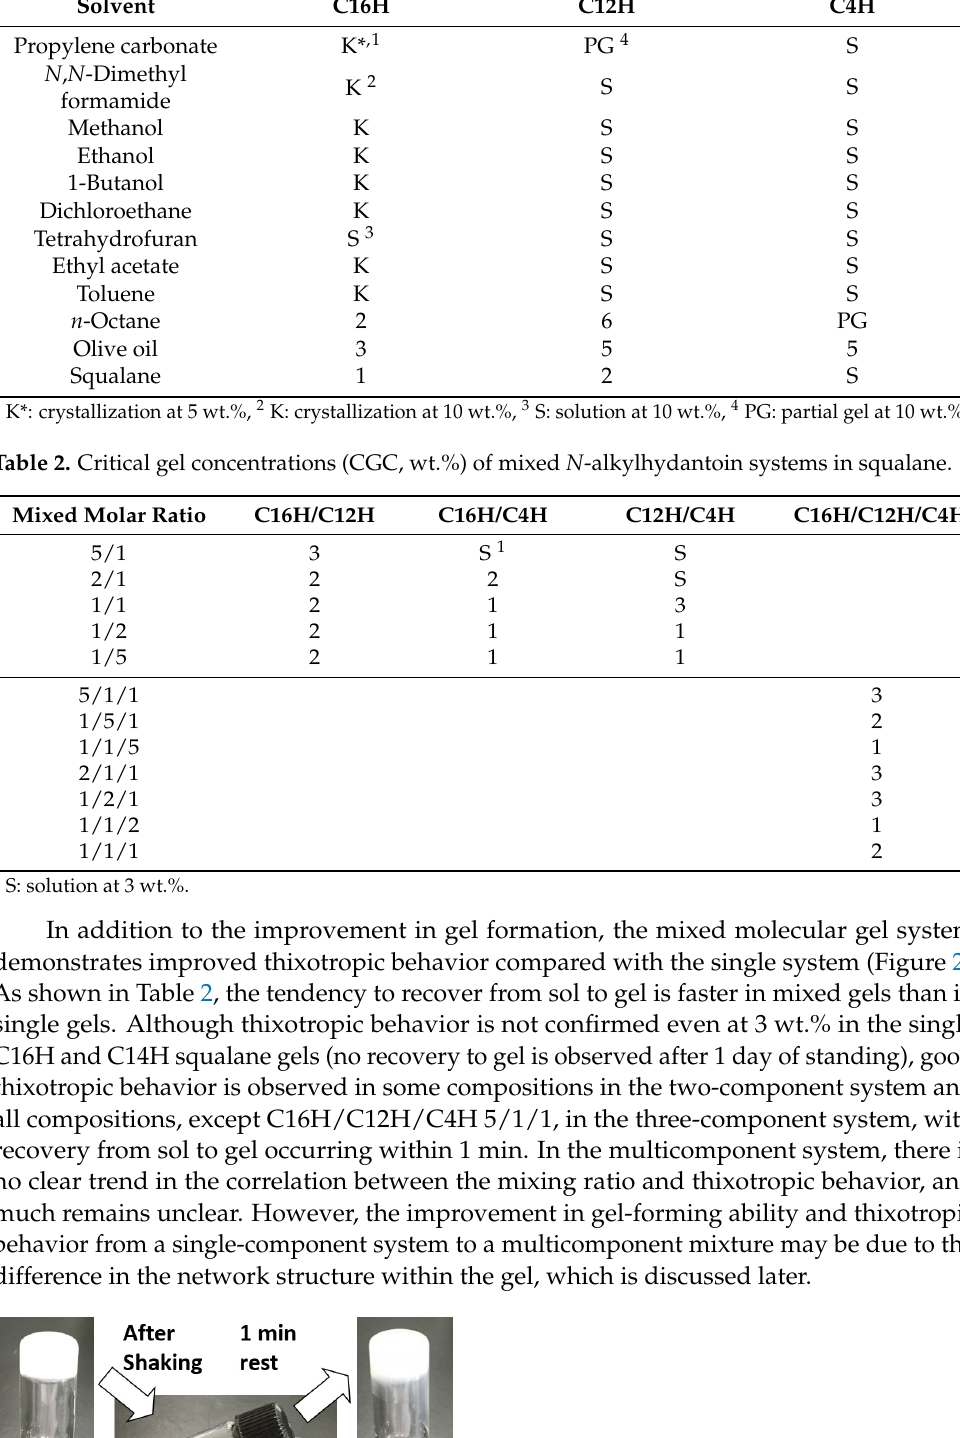
Table 1. Critical gel concentrations (CGC, wt.%) of N -alkylhydantoins in organic solvents. Solvent